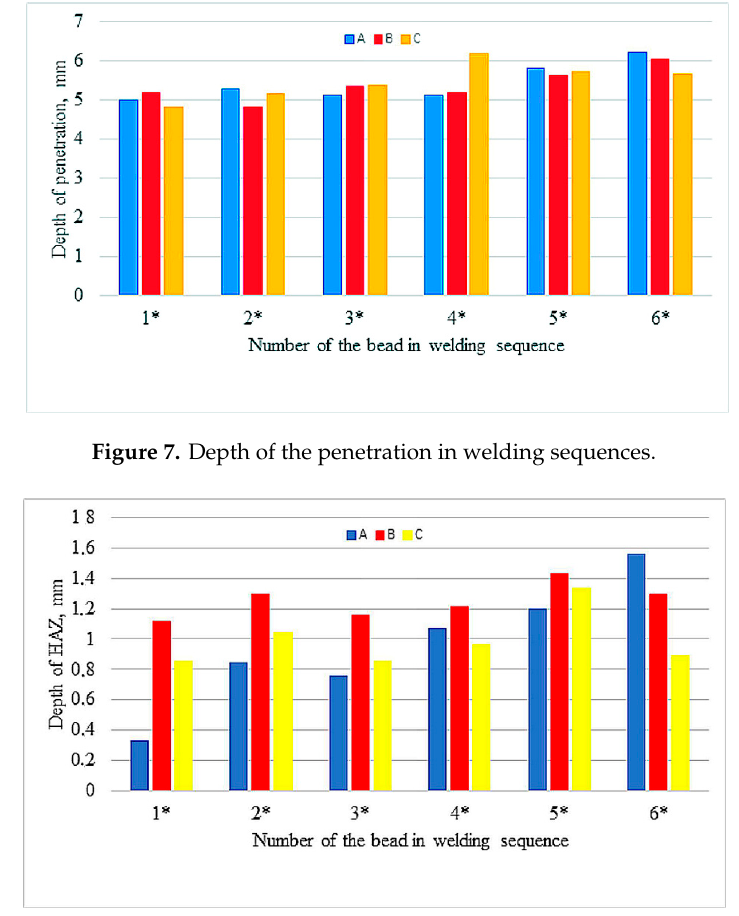
Figure 8. Depth of the HAZ in welding sequences.